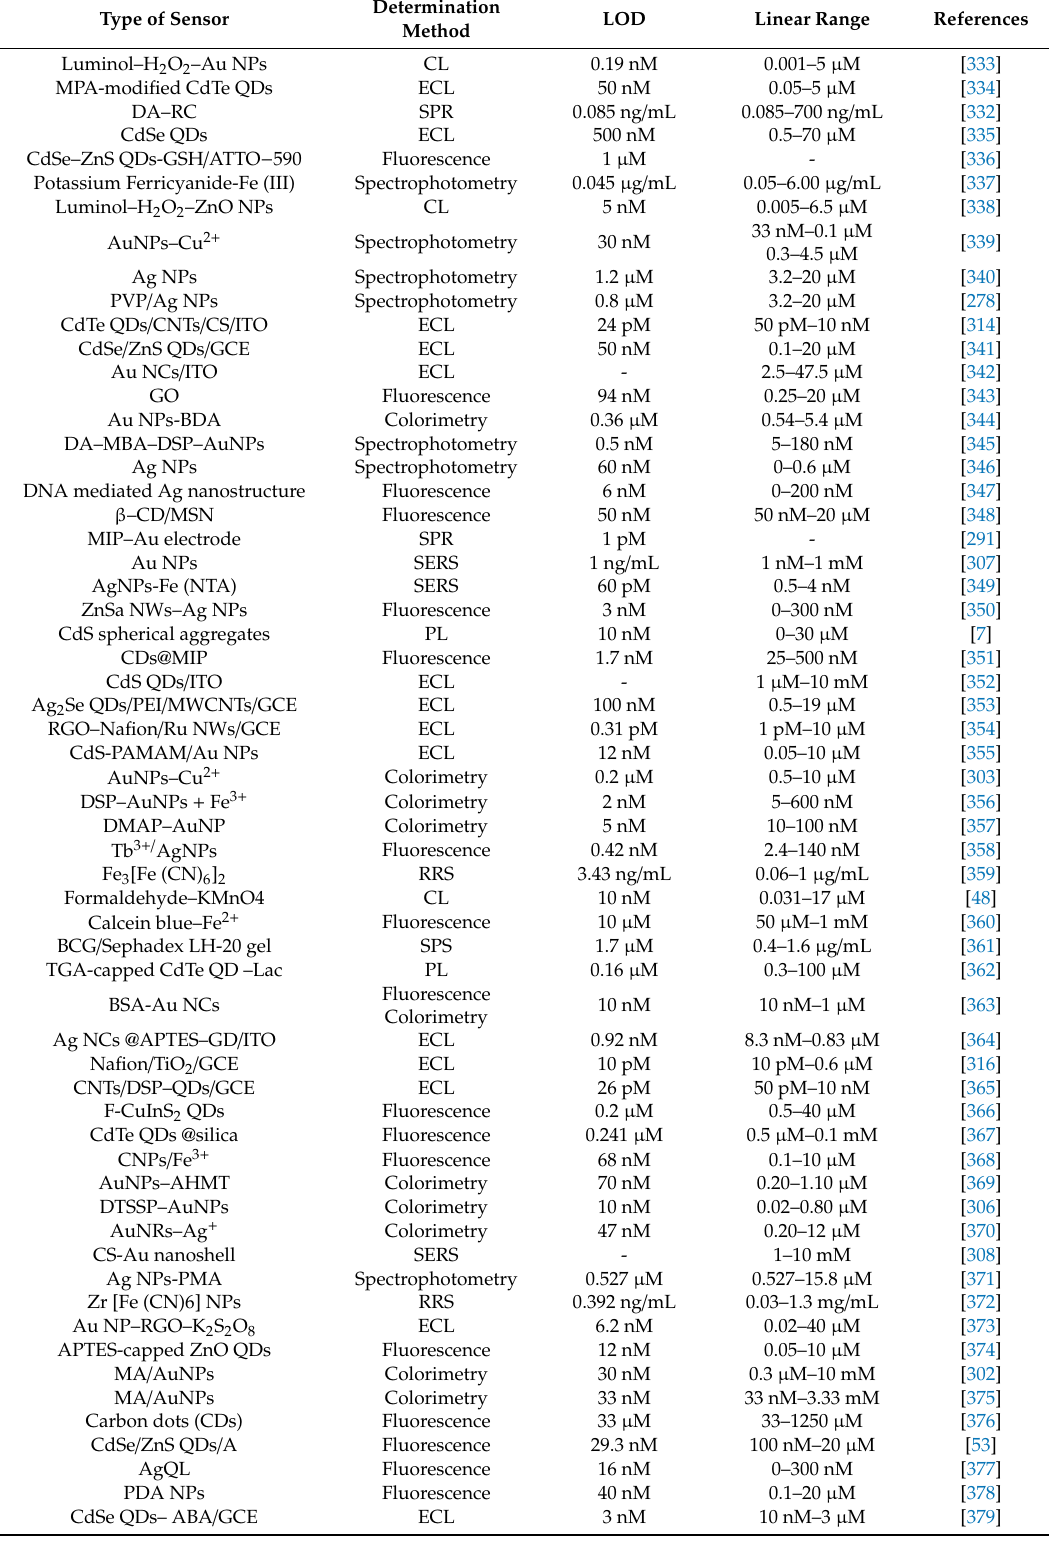
Table 3. DA optical